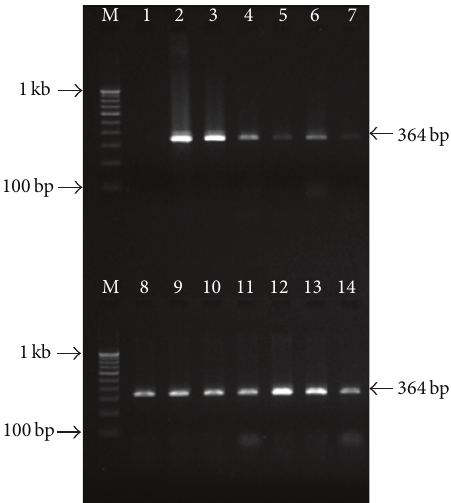
Figure 1: Gel picture showing the nested PCR amplification target- ing flagellin ( fliC ) gene of S . Typhi in clinical specimens. Lane M, 100bp DNA ladder; lane 1, negative control; lane 2, positive control ( S. TyphiMTCC3216);lanes3–14,positivenestedPCRamplification in different clinical samples.